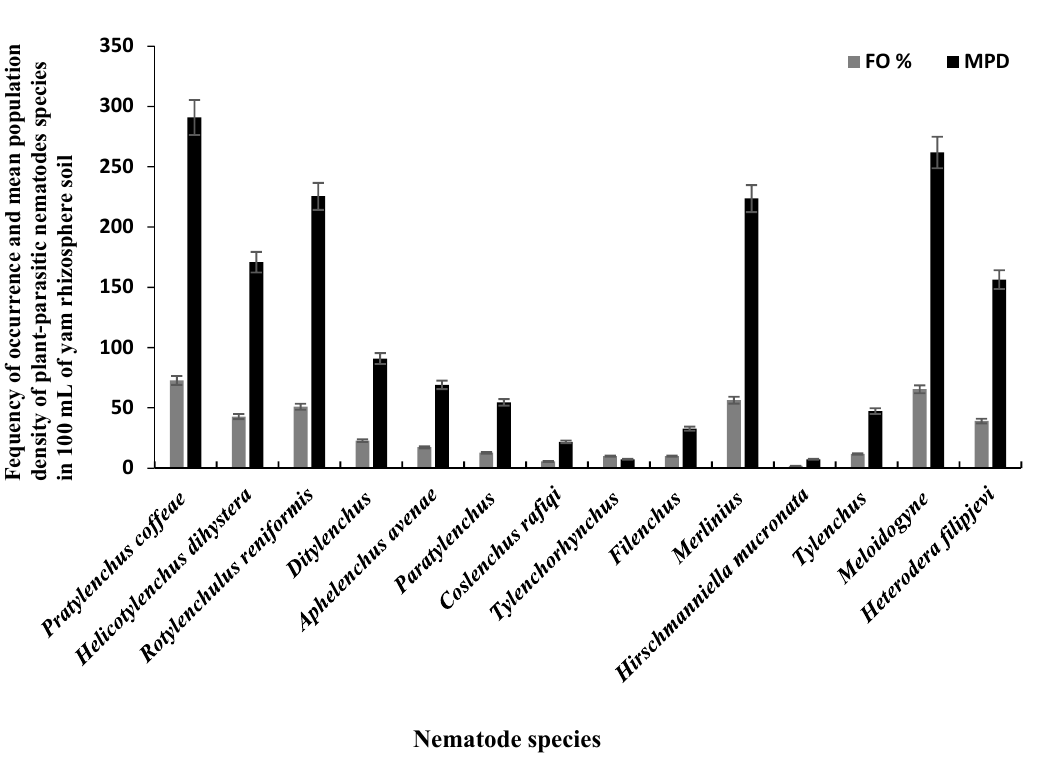
Biology 2021 , 10 , x FOR PEER REVIEW Figure 1. Mean population densities (MPD) and frequencies of occurrence (FO) of plant-parasitic nematodes species recovered from yam rhizosphere in Jiangxi and Shandong provinces of south-east China.